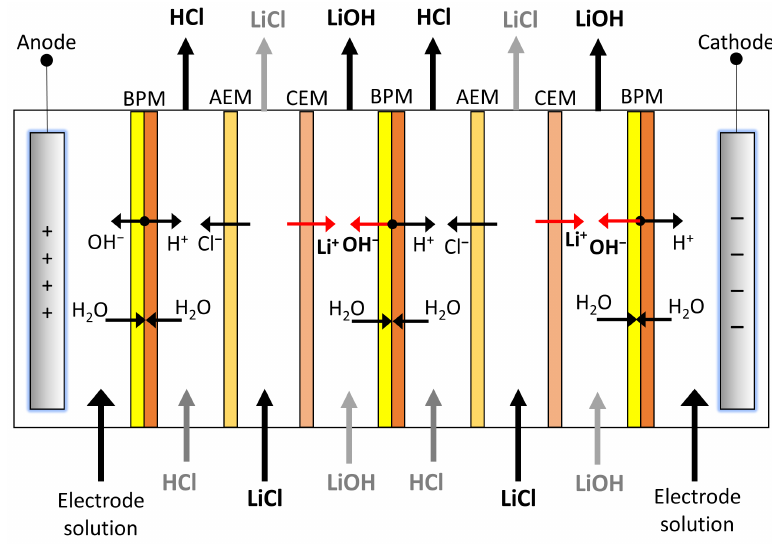
Figure 1. LiOH production scheme from LiCl by BMED with two compartments. BPM: Bipolar membrane, AEM: Anion Exchange membrane, CEM: Cation Exchange membrane.